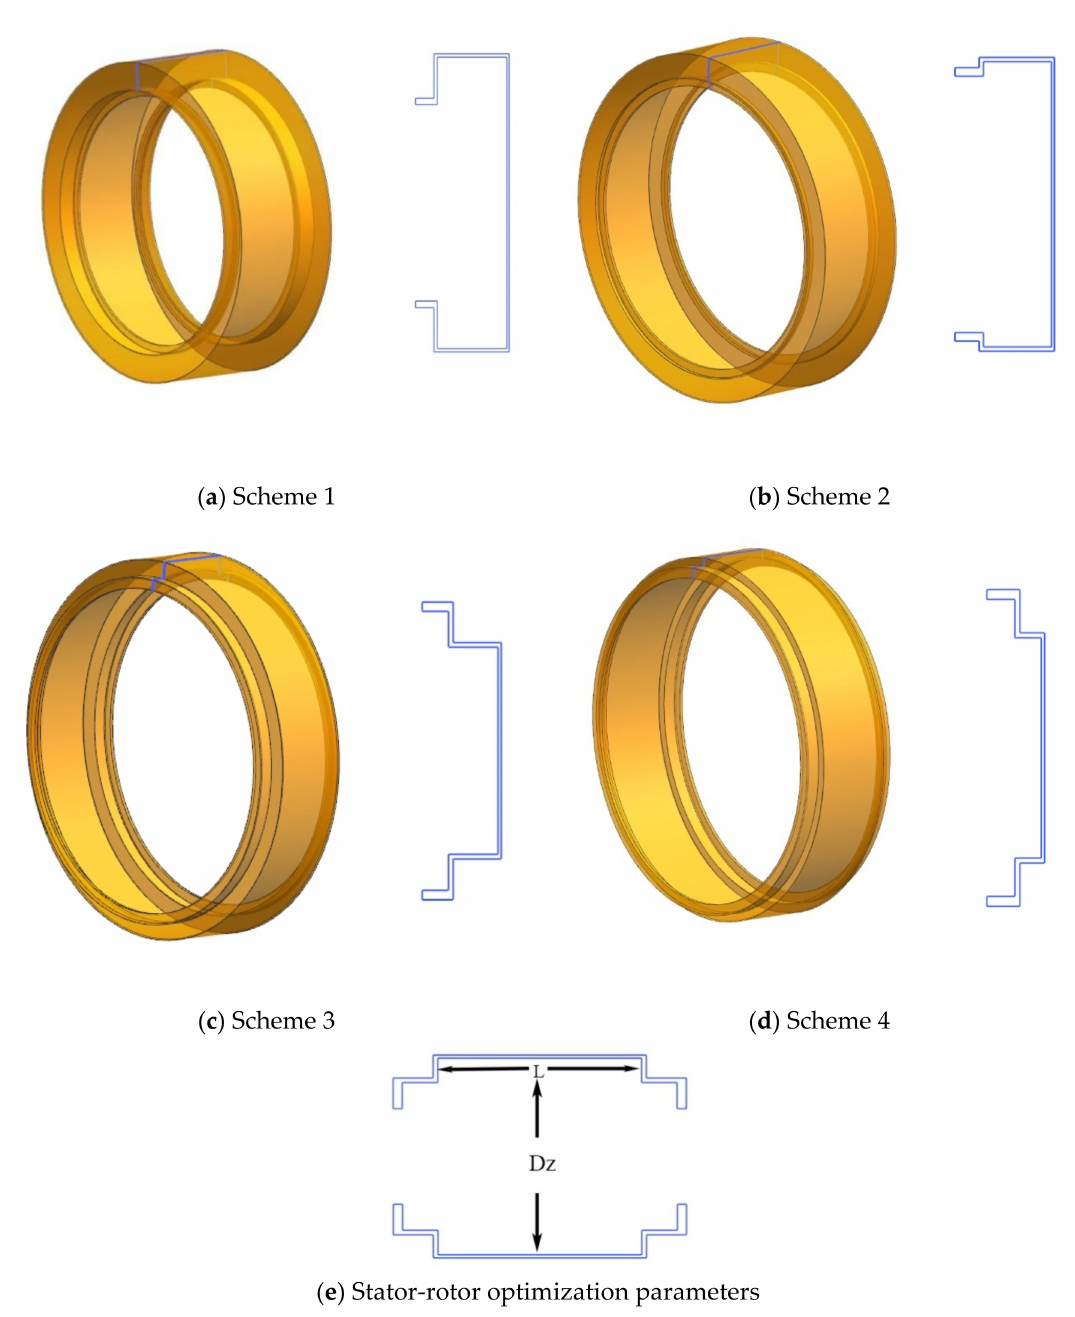
Figure 17. The cavity rotor structure. ( a ) Scheme 1, ( b ) Scheme 2, ( c ) Scheme 3, ( d ) Scheme 4, ( e ) Stator-rotor optimization